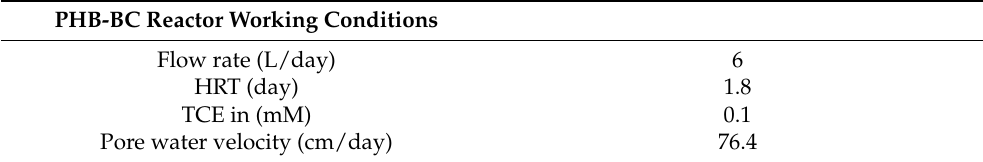
Table 1. Some operating parameters set at the beginning of the